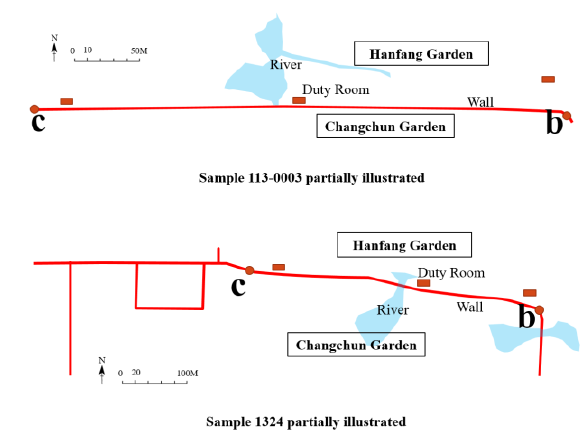
Figure 2. Analysis of the eastern boundary of the northern wall of Changchun Garden.